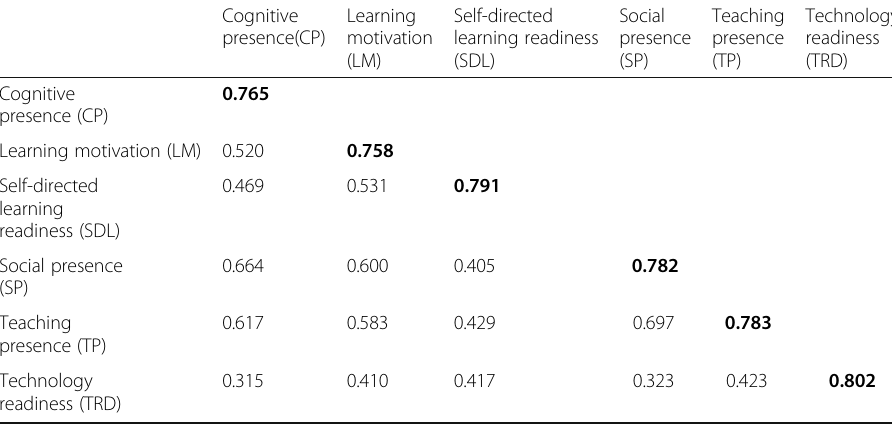
Cognitive presence(CP)